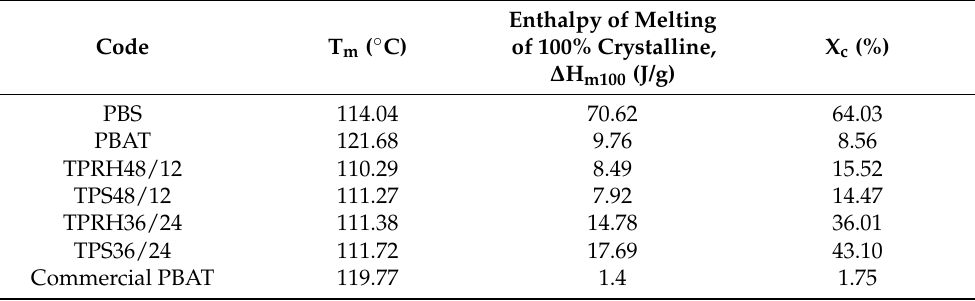
Table 4. Thermal properties of bare PBAT, bare PBS, PBAT/PBS/RH blends, and PBAT/PBS/TPS